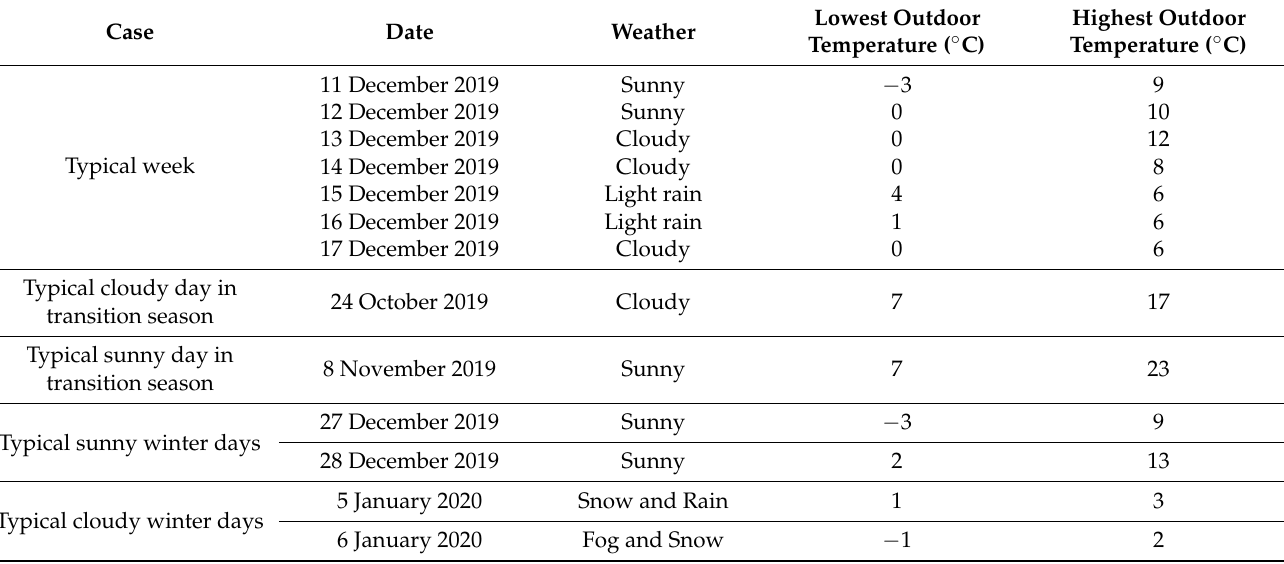
Table 3. Typical daily meteorological